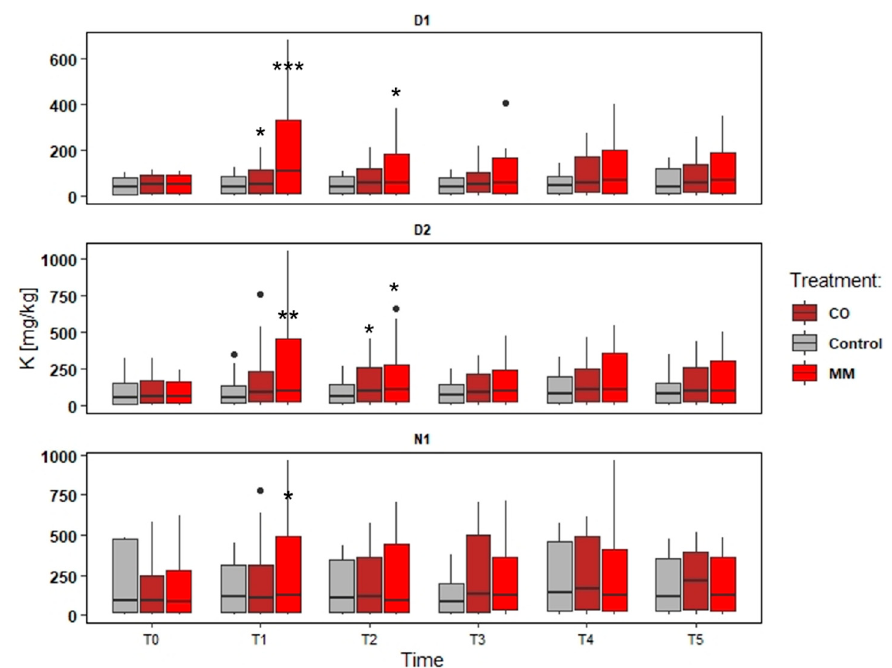
Figure 5. Potassium content (available K) trends (T0–T5) in three experimental fields (D1, D2, and N1) comparing soil amended with compost from digestate (CO), soil amended with matured manure (MM), and soil without amendment application (Control). The significantly different means per sampling date (T0–T5) are identified through asterisks; *** = p > 0.001; ** = p > 0.01; * = p > 0.05; • = outliers.